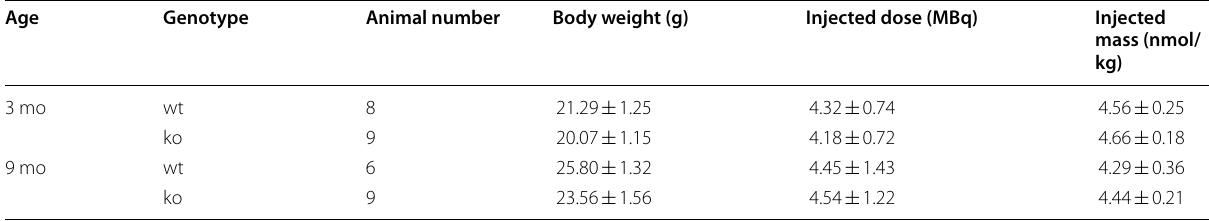
Parameters are expressed as mean mo